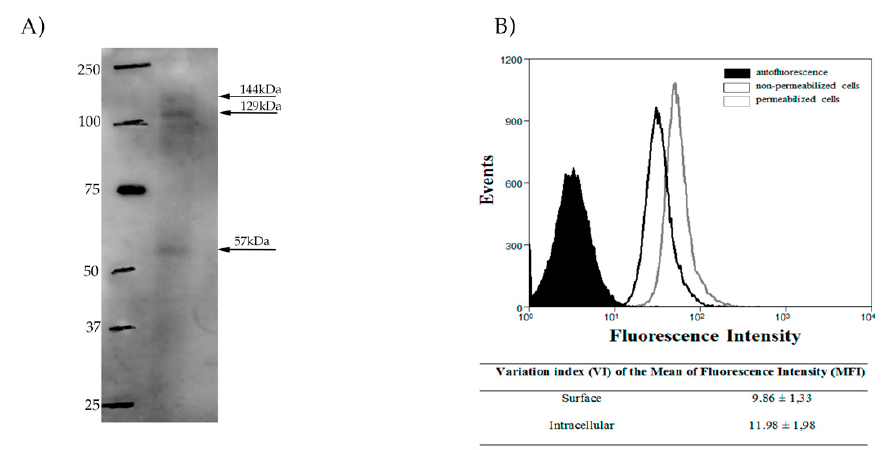
Figure 1. Detection of subtilisin in L. amazonensis . ( A ) Western blot analysis of L. amazonensis (MHOM/BR/77/LTB0016) promastigotes (30 µg of lysate) using an anti-subtilisin antibody (1:500) and an anti-rabbit secondary antibody (1:4000). The subtilisin-like protein bands are indicated by the black arrows. ( B ) Flow cytometry analysis of Triton X-100-permeabilized (grey line) and non-permeabilized (black line) L. amazonensis promastigotes labeled with the anti-subtilisin antibody (1:400) and an Alexa 488 secondary antibody (1:750). The variation index of the mean fluorescent intensity (MFI) was obtained by the division of the MFI from labeled parasites by the non-stained autofluorescence control (black fill). Experiments were performed in triplicate and graphs are representative of three independent experiments.